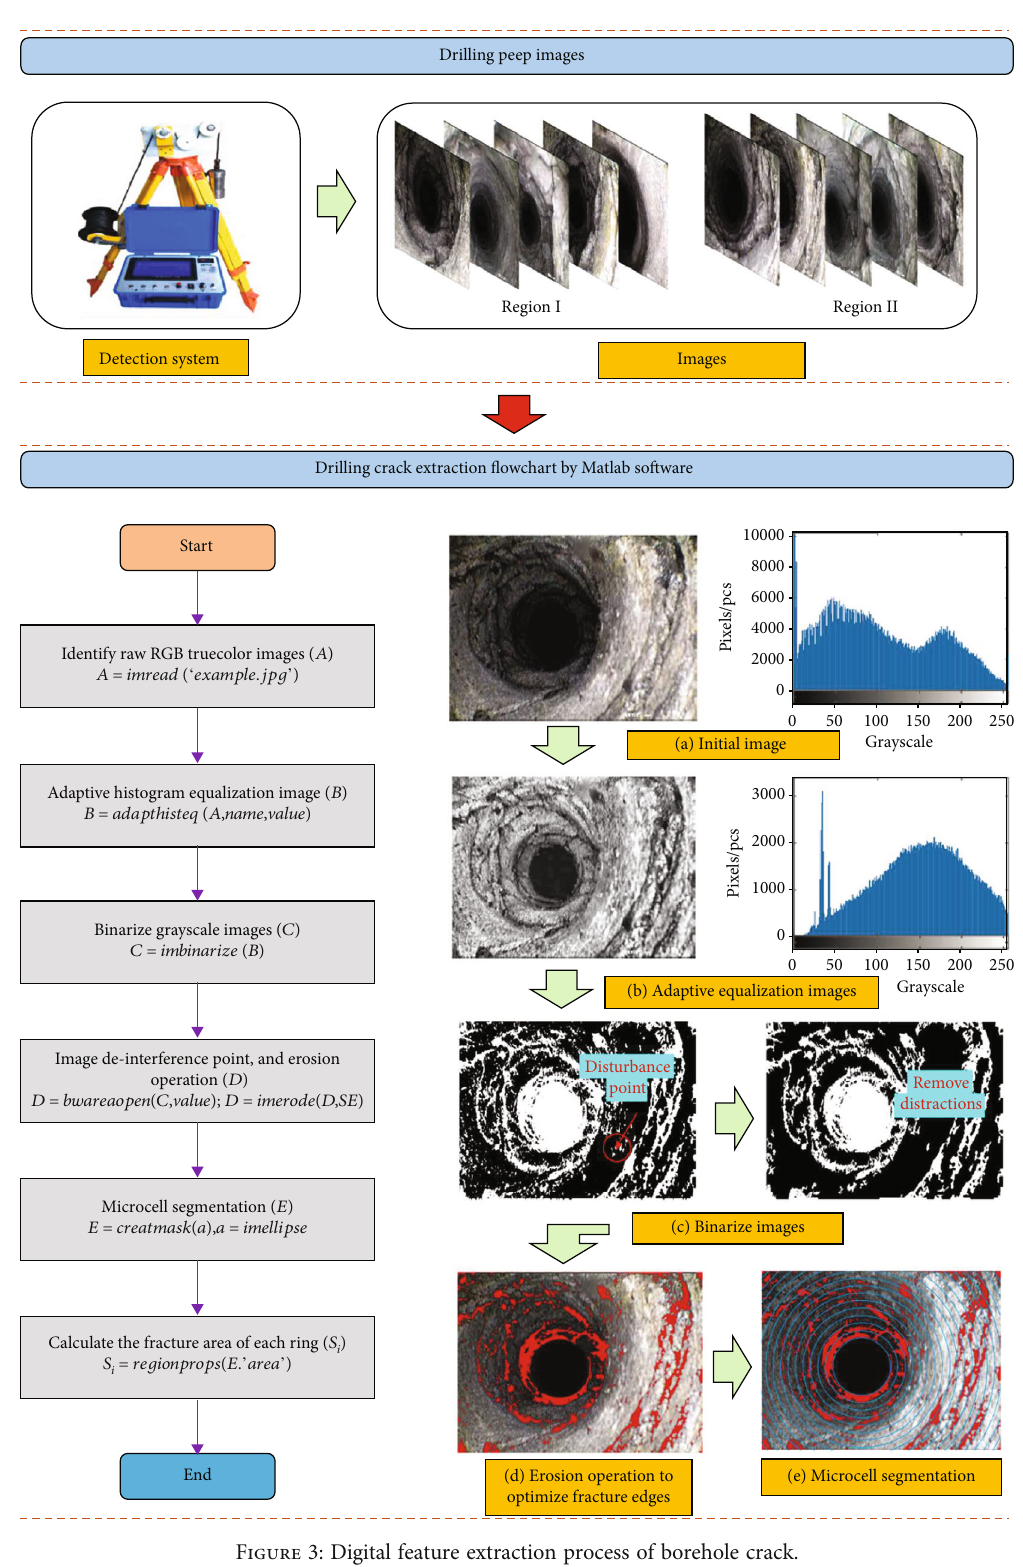
Figure 3: Digital feature extraction process of borehole